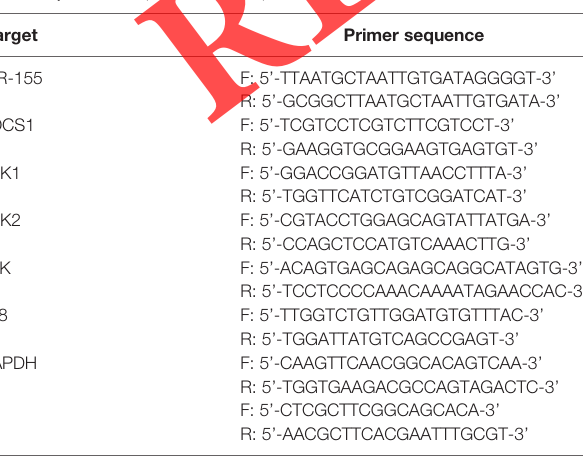
TABLE 1 | Primer sequences of